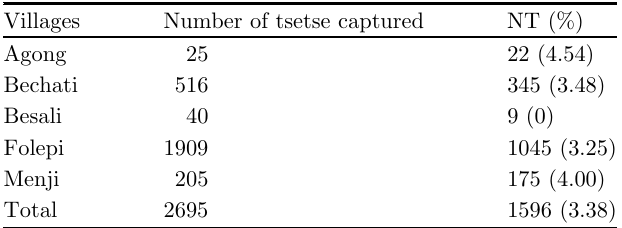
Table 2. Tsetse fl y mid-gut infections with T. congolense “ forest type ” according to